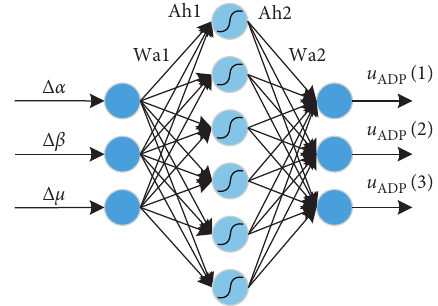
Figure 4: Structure of the action